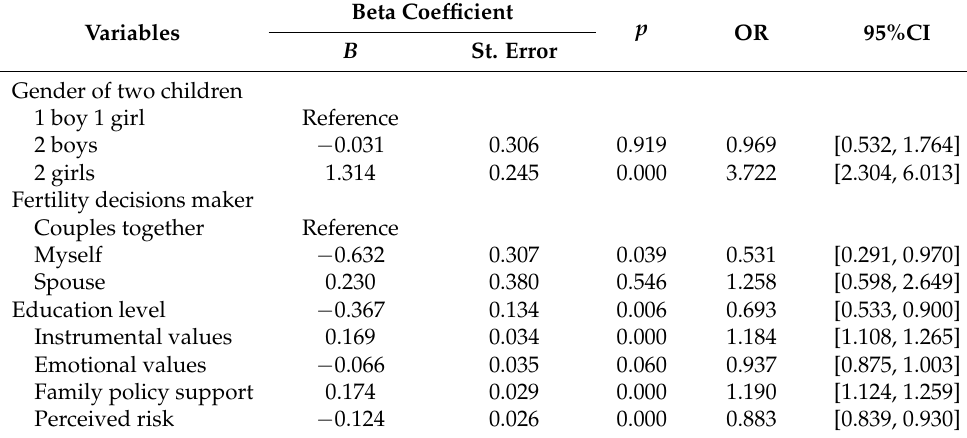
Table 4. Logistic regression analysis for factors impacting intention to have a third